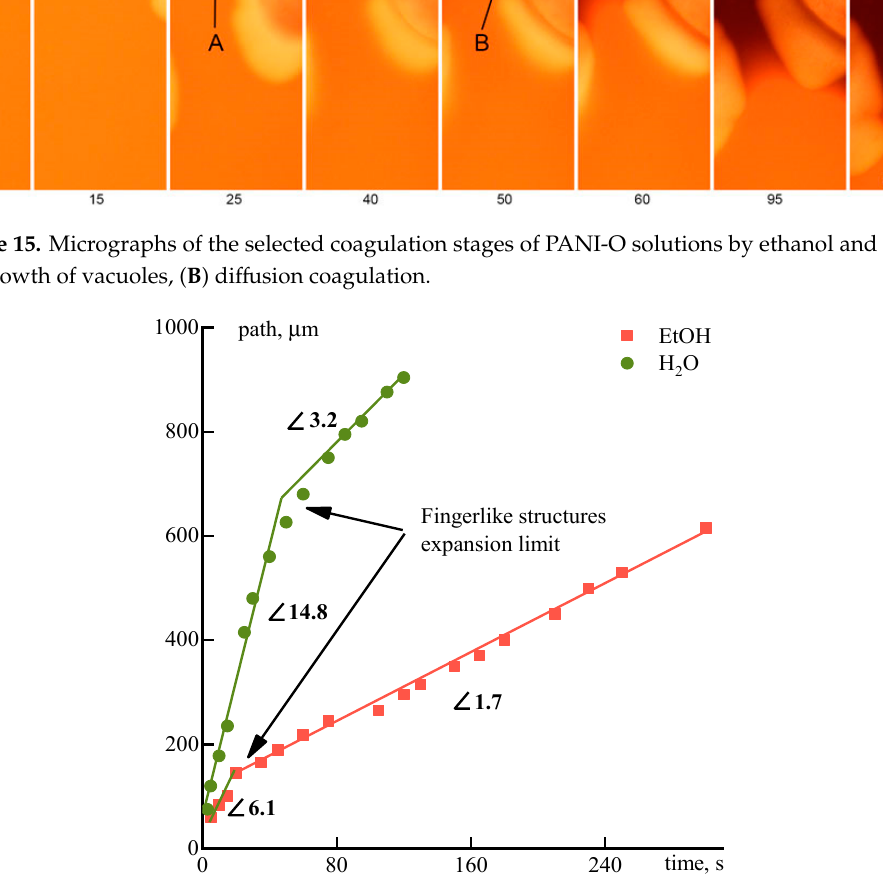
Figure 16. Coagulation front movement in a drop of a solution under the action of ethanol and water.